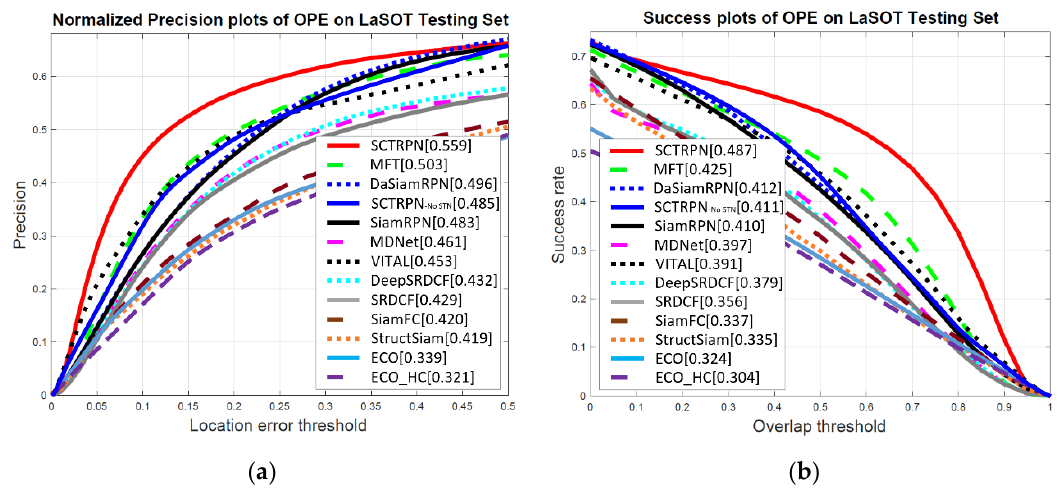
Figure 10. Precision and success plots show a comparison of our SCTRPN tracker with state-of-the-art trackers on the UAV123 dataset. ( a ) Precision plots of OPE on UAV123; ( b ) Success plots of OPE on UAV123.